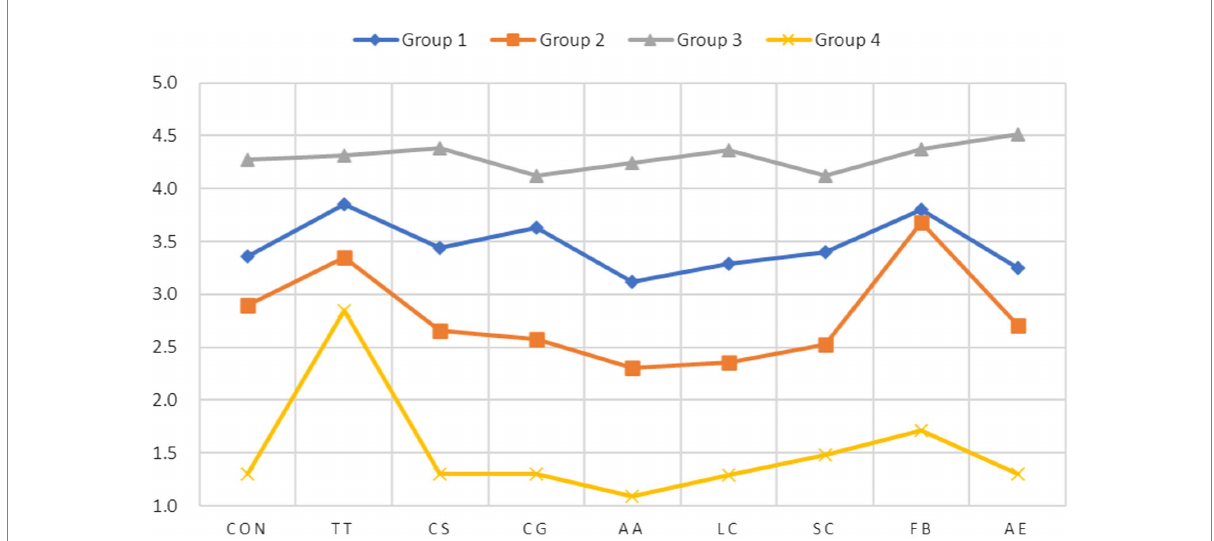
FIGURE 2 Profile plot of four-group LCFA Model of FFE . CON, concentration on the task at hand; TT, transformation of time; CS, challenge-skill balance; CG, clear goals; AA, action-awareness merging; LC, loss of self-consciousness; SC, sense of control; FB, unambiguous feedback; and AE, autotelic experience. The y -axis listed item-average scores and the x -axis presented flow